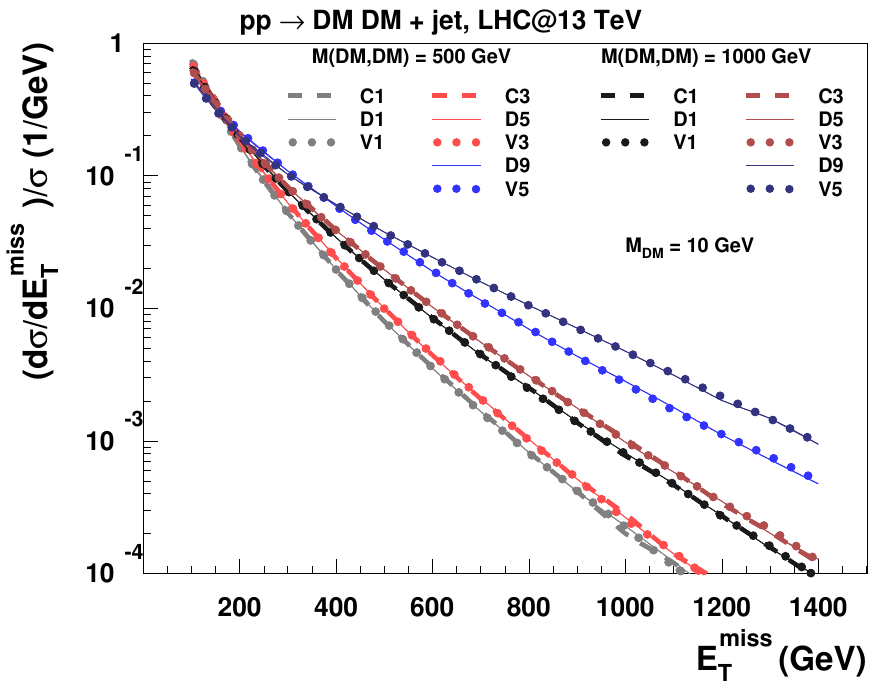
Figure 3 . d(cid:27)=d E miss parton level distribution normalised to unity for the (cid:12)xed invariant mass of T the DM pair, M inv ( DM; DM )=500 and 1000 GeV for (C1,D1,V1), (C3,D5,V3) and (D9,V5) groups of representative operators with the scalar, vector and tensor structure of SM part